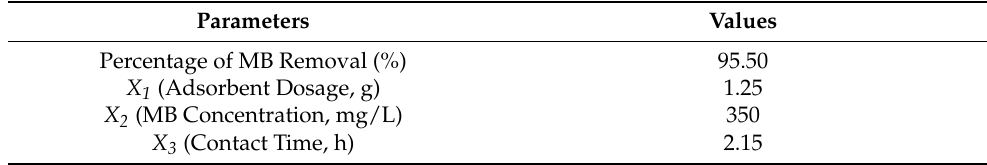
Table 4. Values of process parameters for the maximum MB removal